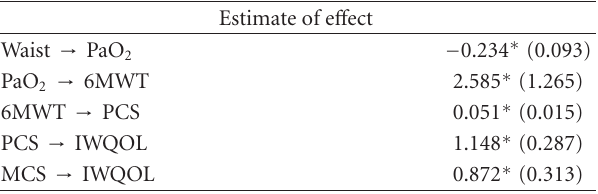
Table 4: Subpath estimates from the path